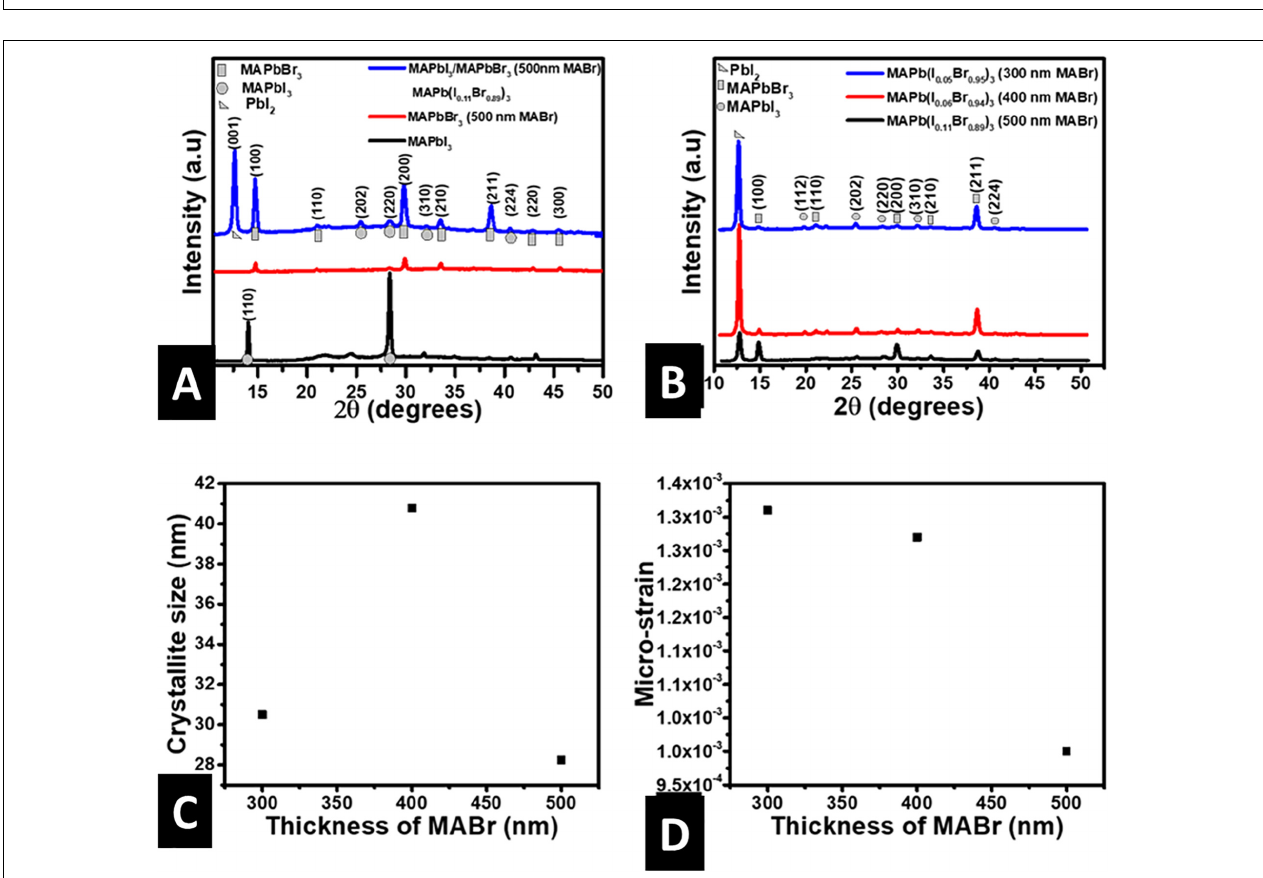
FIGURE 1 | Schematic diagrams showing the synthesis process of thin MAPb(I 1 - x Br x ) 3 alloy film and the structure of FTO/c-TiO 2 /m-TiO 2 /MAPb(I 1 - x Br x ) 3 /Au. (A) Synthesis of MAPbI 3 by SPVD, (B) synthesis of MAPbBr 3 by SPVD, (C) the FTO/MAPb(I 1 - x Br x ) 3 /Au solar cell architecture, (D) mesoporous